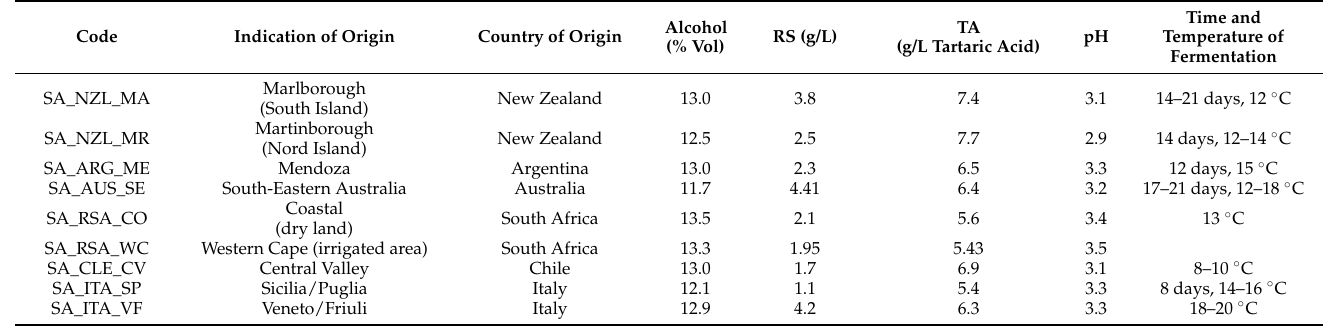
Table 2. Code, origin, and basic oenological parameters of Sauvignon Blanc samples (RS, residual sugars; TA, titratable acidity). The alcohol degree (%vol), RS (g/L), and TA (g/L tartaric acid) were analysed by official methods according to OIV